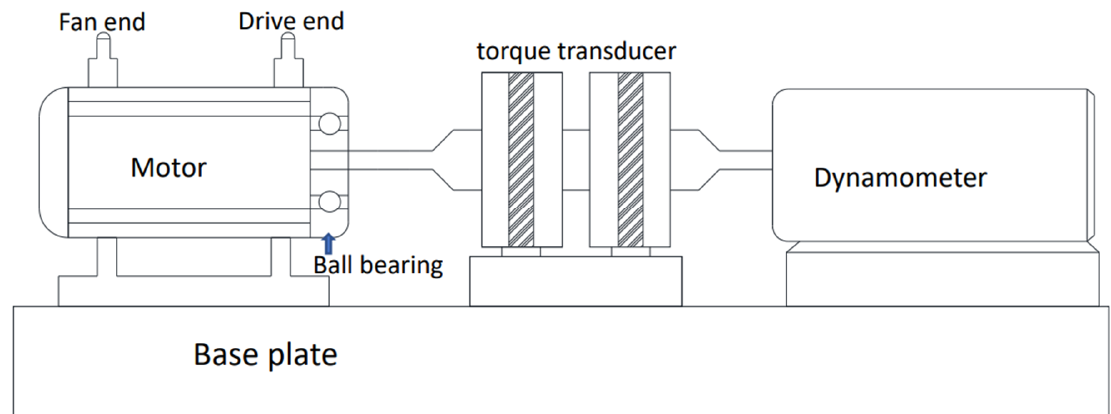
Figure 1. Experimental platform of the CWRU bearing test rig for a ball bearing system.